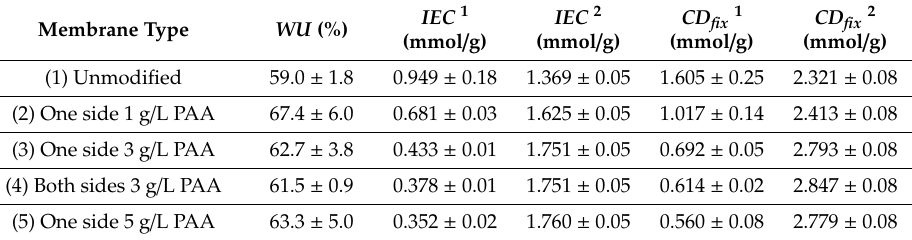
Table 2. Water uptake ( WU ), ion exchange capacity ( IEC ), and fixed charge density ( CD fix ) results of the prepared